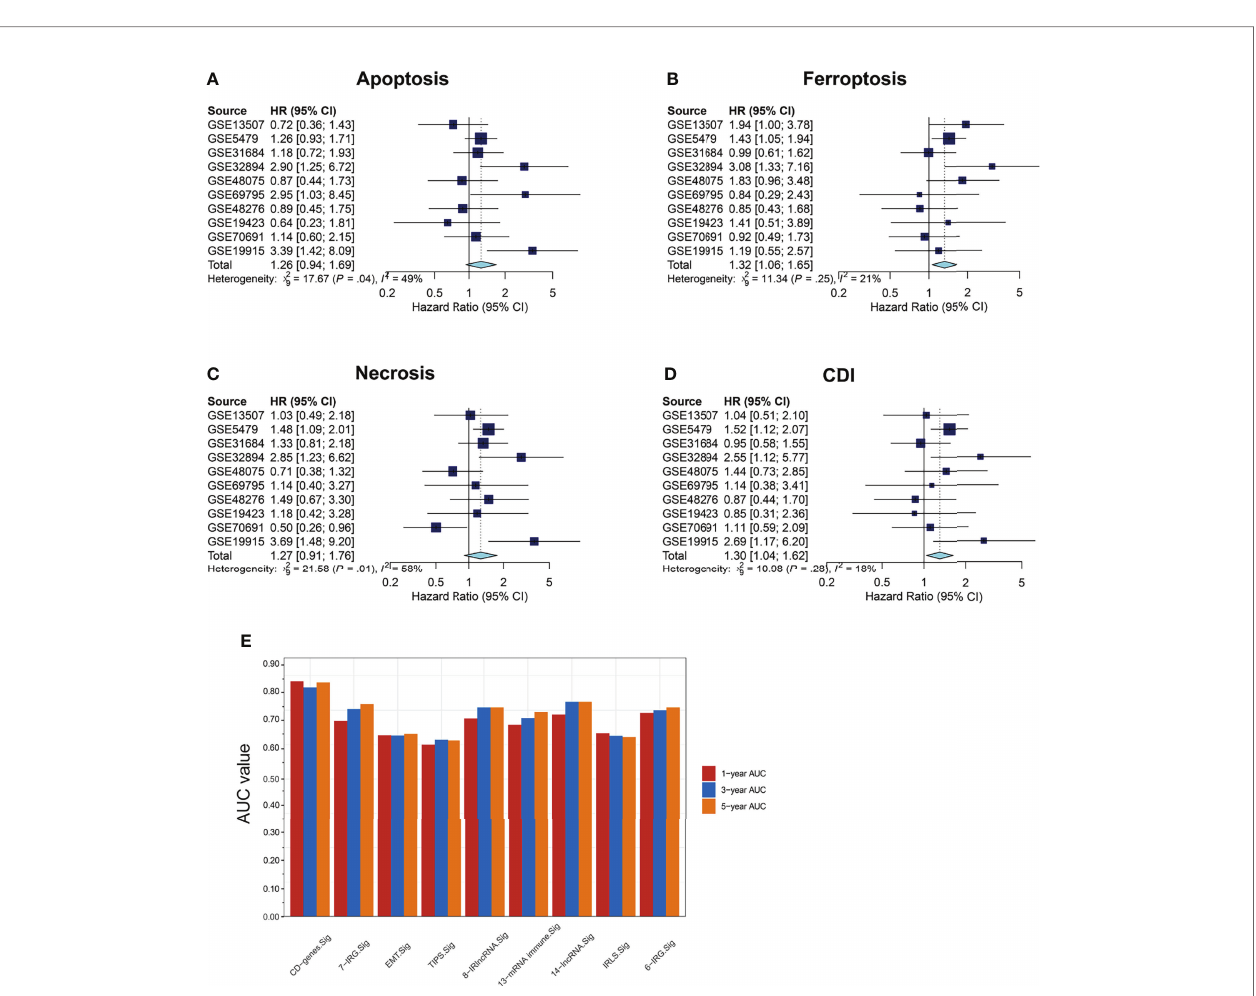
FIGURE 5 | Survival meta-analysis of cell-death pathways. (A – D) Meta-analysis of the predictive values of apoptosis, necrosis, ferroptosis, and CDI for prognosis in 1531 BCa samples with transcriptomic data from 10 independent cohorts. (E) AUC values of patients at 1, 3, and 5 years were represented by a